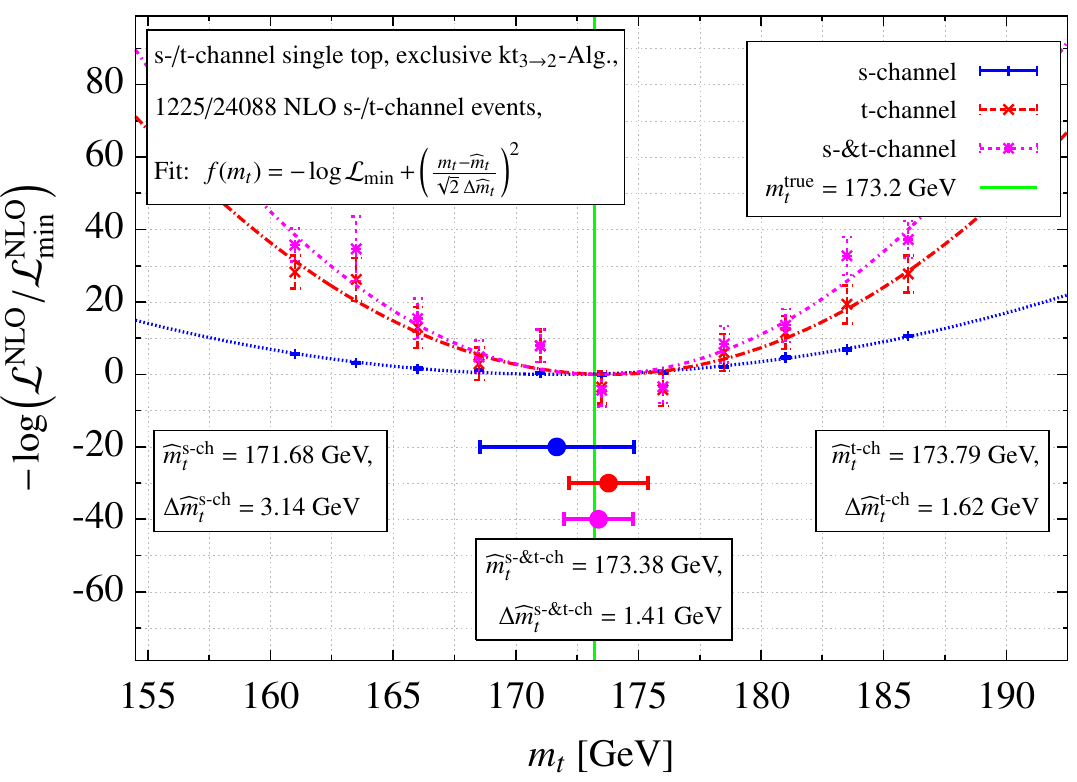
Figure 20 . Extraction of the top-quark mass for a (cid:12)xed